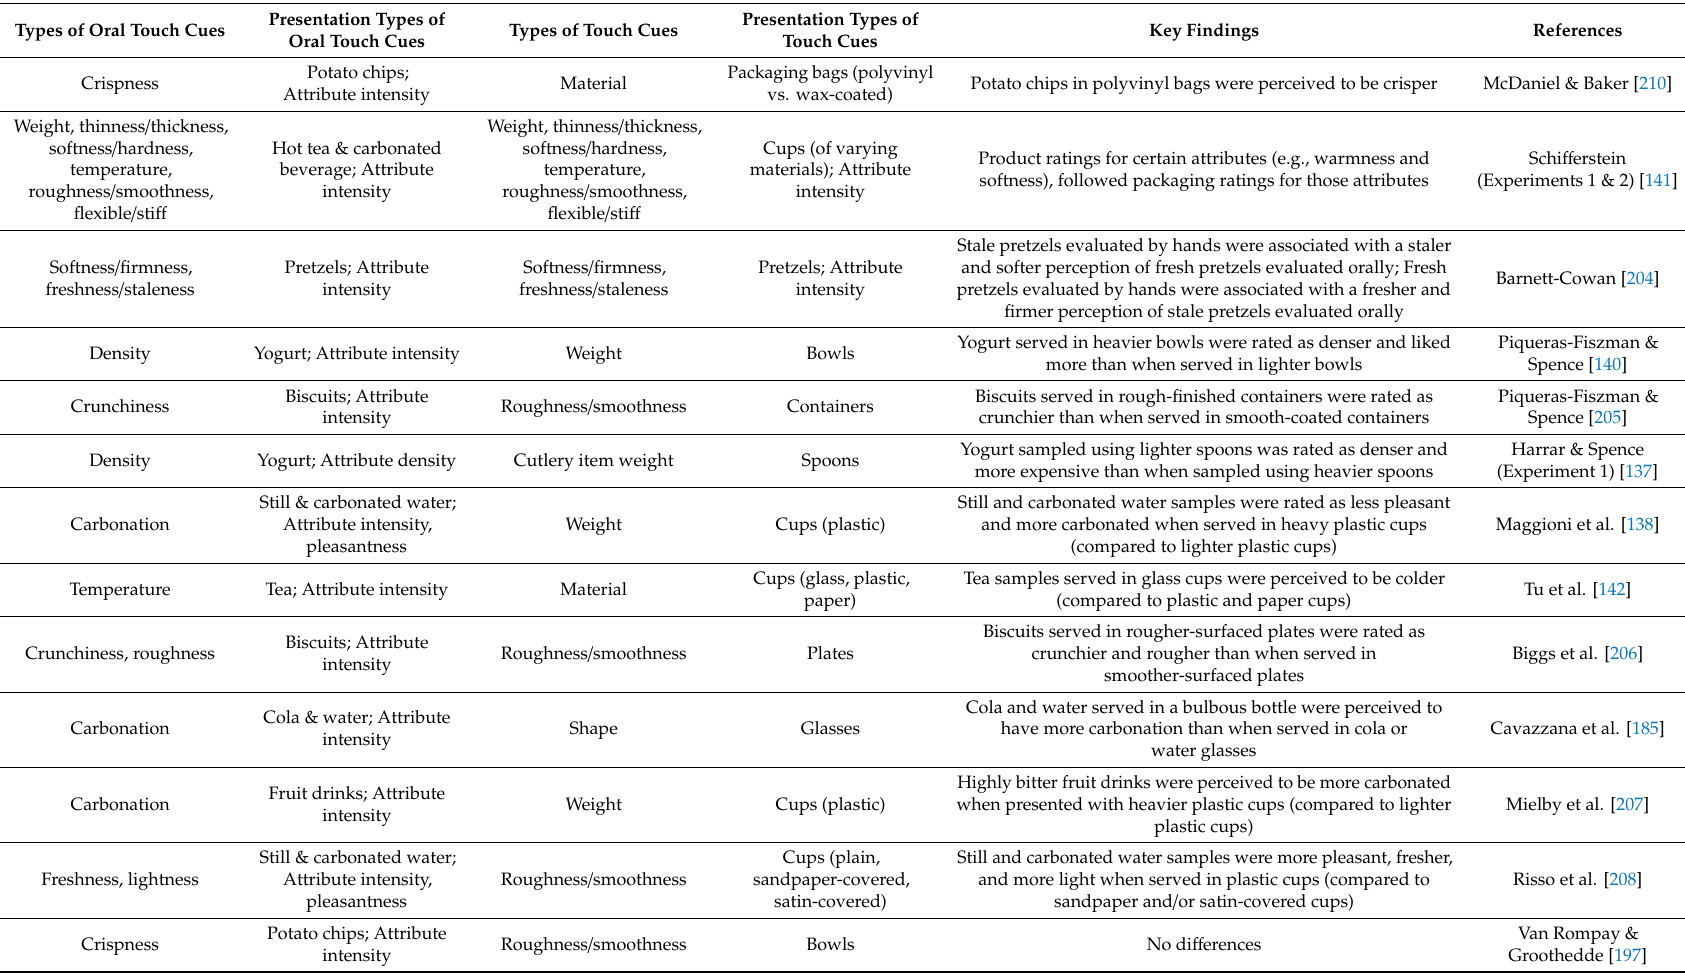
Table 5. The summary of findings regarding cross-modal associations between oral and hand-feel touch